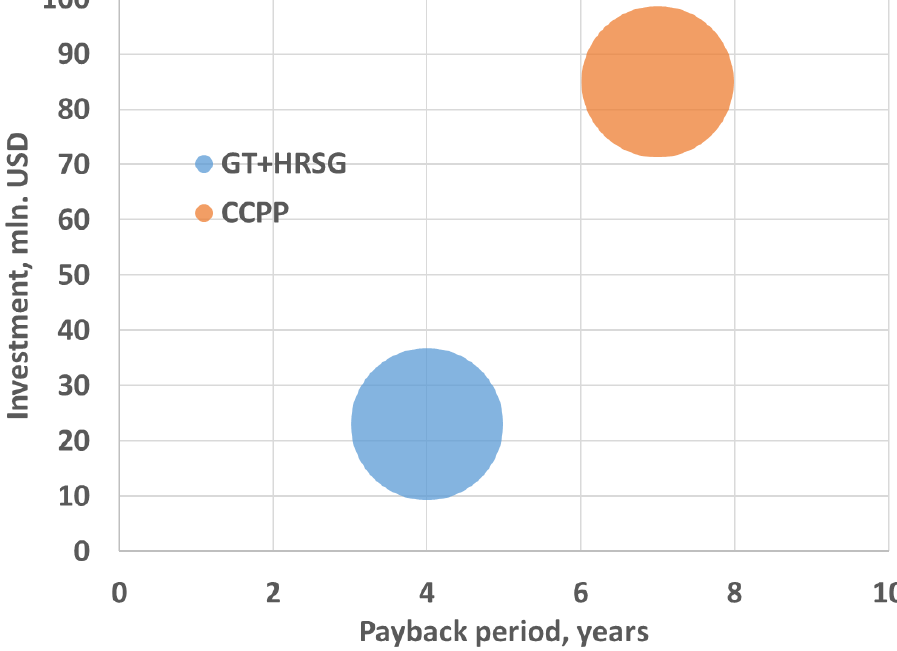
Figure 16. Payback periods for projects.